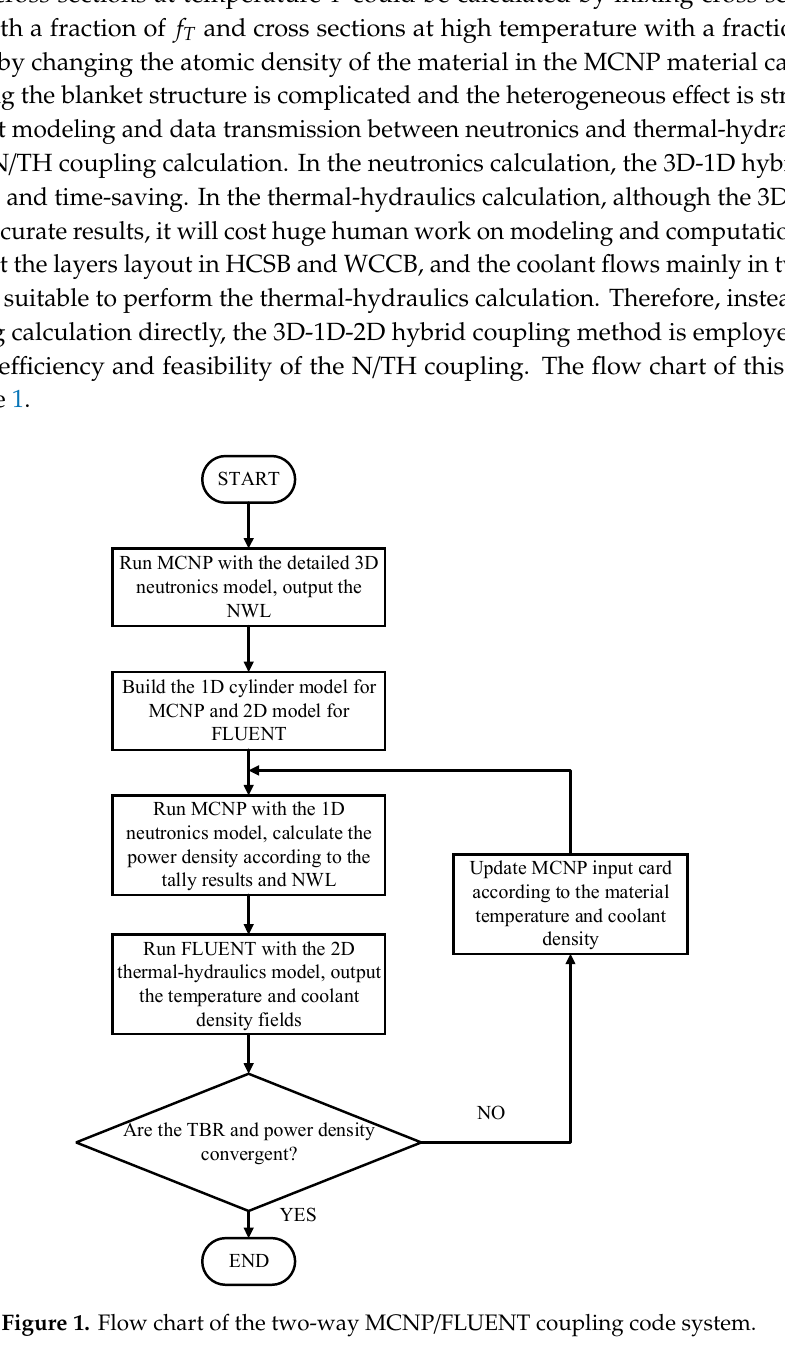
Figure 1. Flow chart of the two-way MCNP/FLUENT coupling code system.